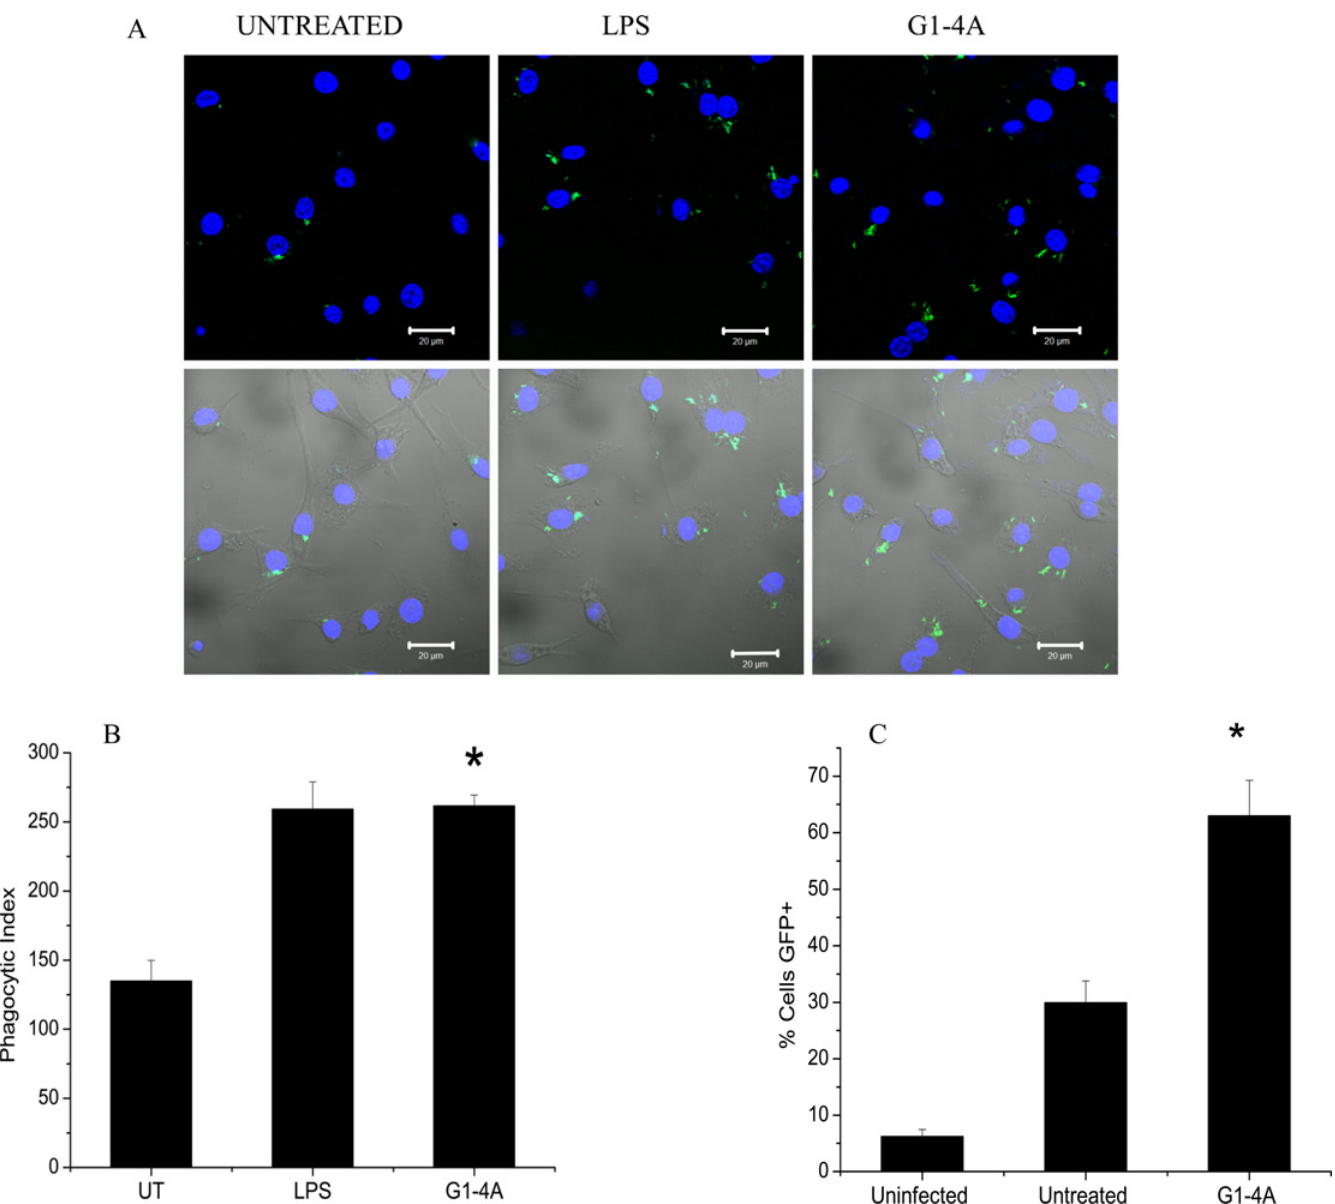
Fig 4. Effect of G1-4A on phagocytic uptake of MTB by RAW cells. (A) Confocal microscopy images of RAW cells infected with GFP tagged MTB H37Rv either treated with G1-4A/LPS or left untreated (DAPI counter stain) (B) Phagocytic index ( * p < 0.01 compared to untreated control) (C) Quantitative representation of percentage of GFP+ cells as analyzed by Flow cytometer. Values of at least three independent experiments presented as Mean ±